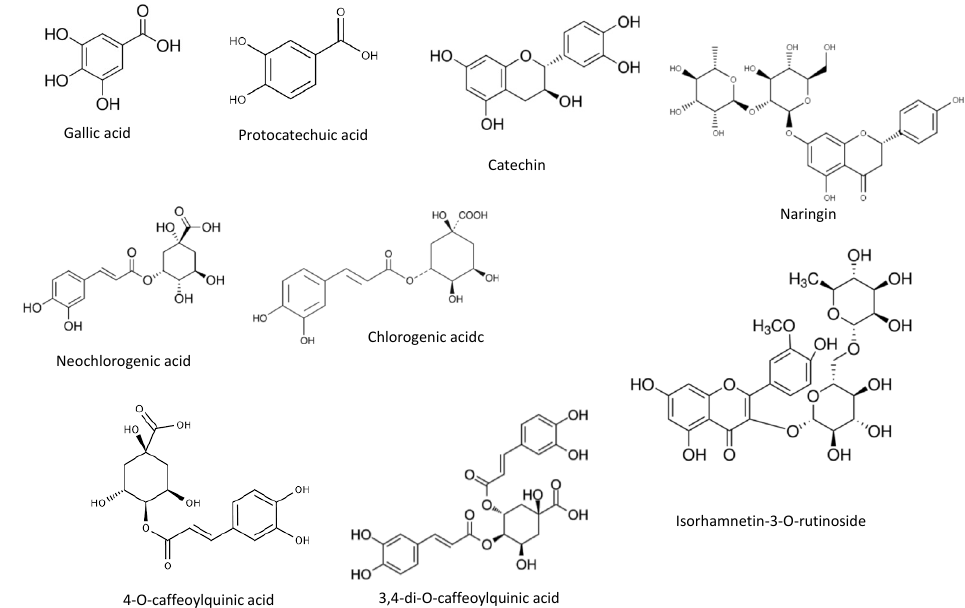
Figure 3. Chemical structures of the principal compounds identified and quantified through HPLC- PDA analysis in the optimal extract from kiwiberry leaves.